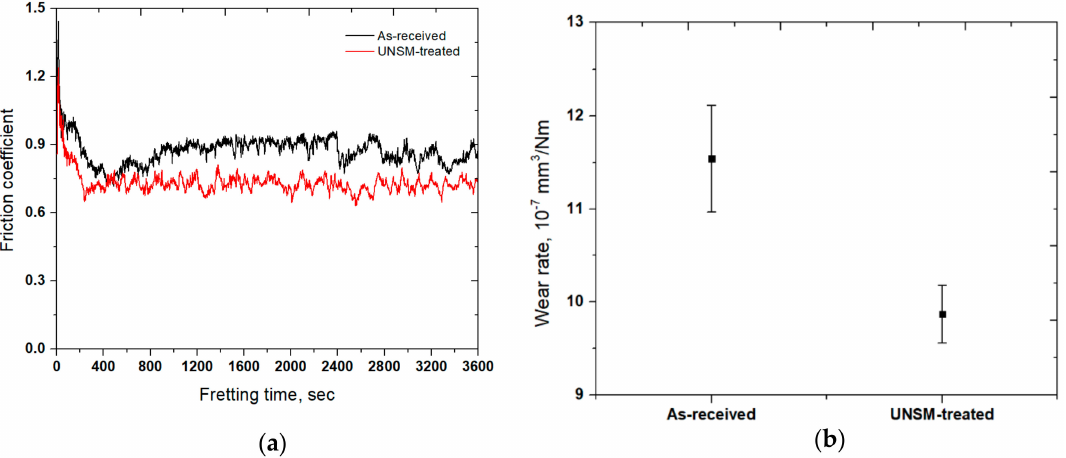
Figure 6. Friction coefficient ( a ) and fretting wear resistance ( b ) of the as-received and UNSM-treated specimens.